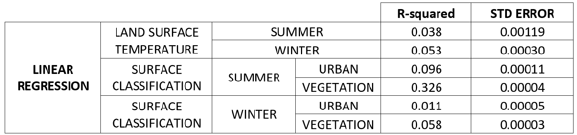
Table 1: Linear Regression